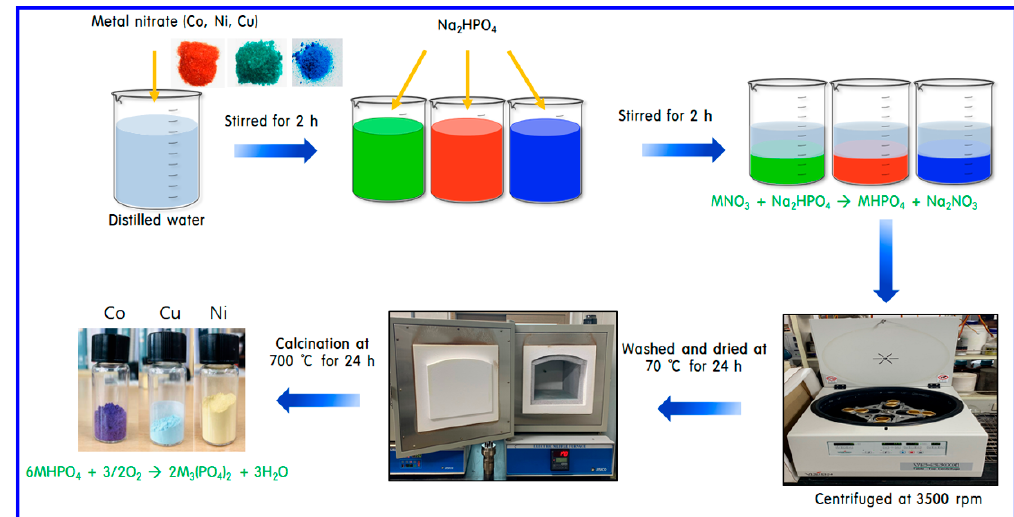
= Co, Ni, and Cu). 3 (PO 4 ) 2 -M 2 P 2 O 7 mpc (M